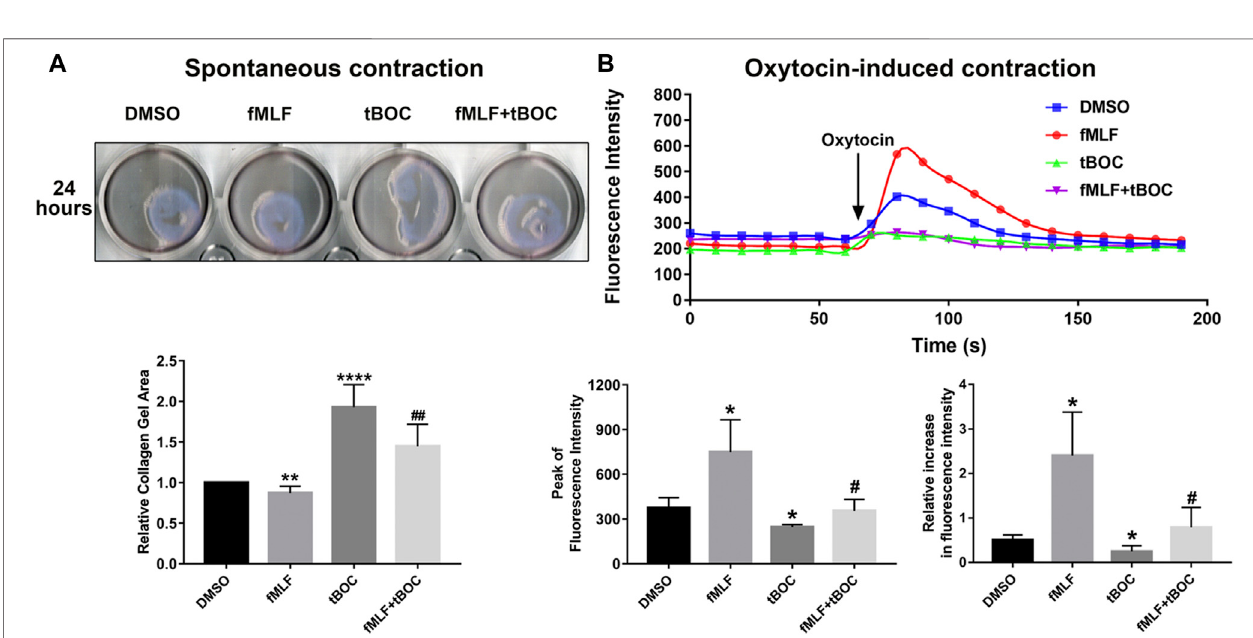
FIGURE 6 | FPR1 activation promotes HutSMC contraction. (A) The effect of FPR1 on spontaneous contraction in HutSMCs treated with DMSO (control), tBOC (5 μ M), fMLF (10 μ M), or fMLF/tBOC combination for 24 h, which was determined by gel areas. (B) The effect of FPR1 on oxytocin-induced contraction in HutSMCs treated with DMSO (control), tBOC (5 μ M), fMLF (10 μ M), or fMLF/tBOC combination for 24 h, which was determined by intracellular calcium concentration. The concentration was re fl ected by fl uorescence intensity. * p < 0.05 compared with control, # p < 0.05 compared with fMLF group.